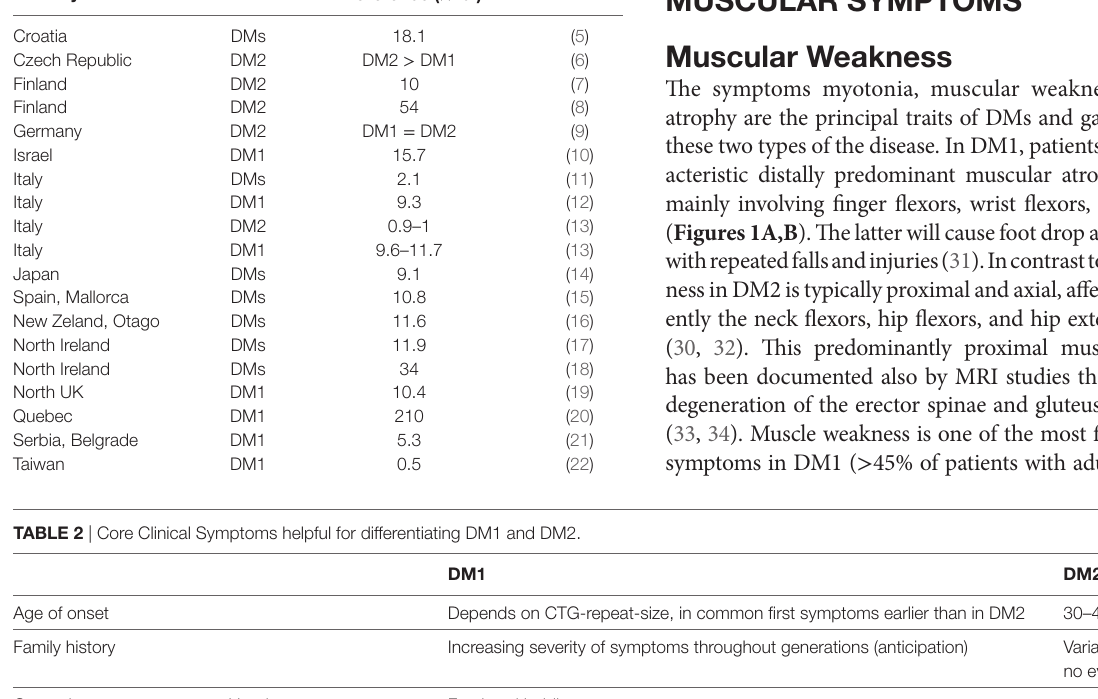
TABLe 1 | Country-specific prevalences of DM1 and DM2.